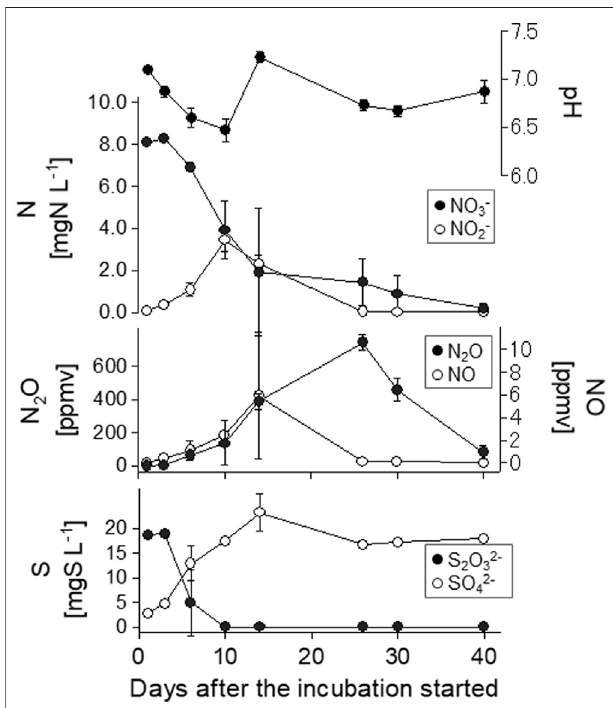
FIGURE 4 | Temporal variations of aquatic and gaseous nitrogen speciesandS 2 O 32 − andSO 42 − concentrationsinI2withN+Streatmentinthe long-term incubation experiment. N, KNO 3 solution; N + S, KNO 3 , and Na 2 S 2 O 3 solution. Error bars indicate standard deviation ( n (cid:2) 3).